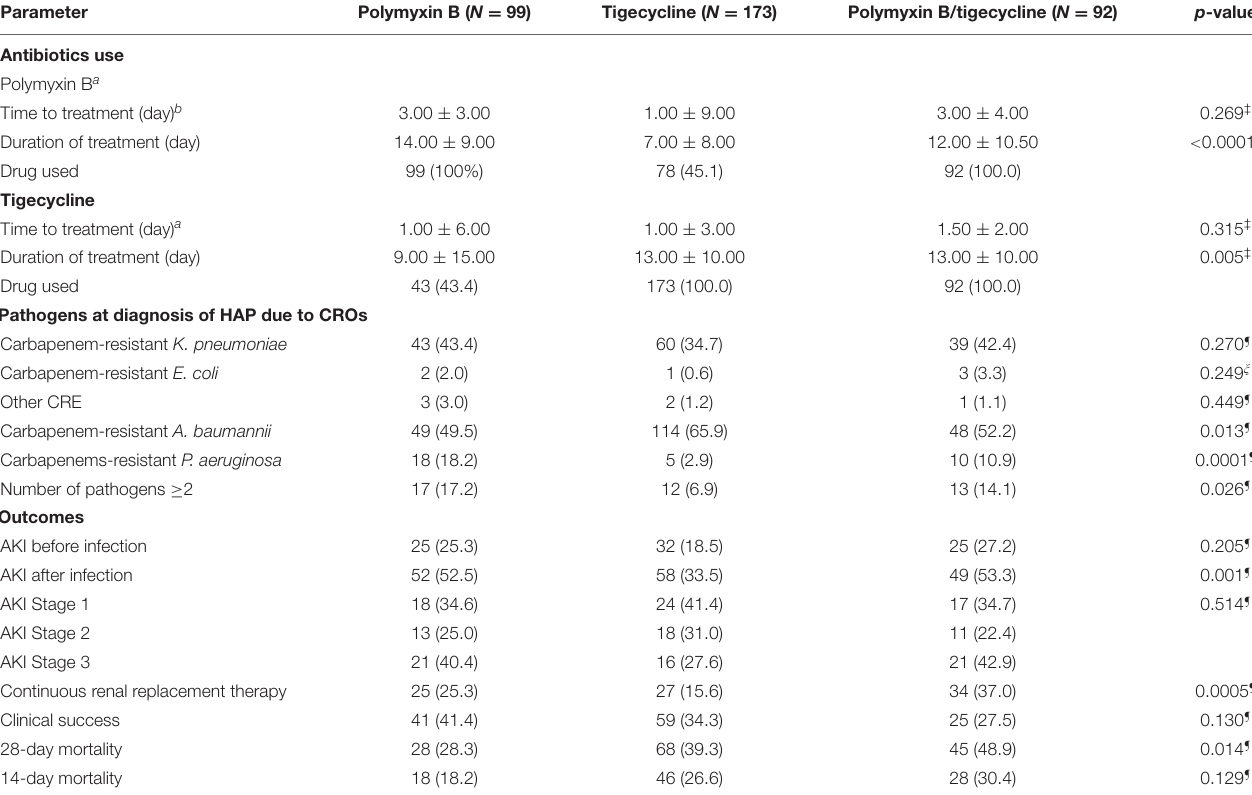
TABLE 2 | Antimicrobial therapies, pathogens, and prognosis of patients in terms of polymyxin B and/or tigecycline treatment.